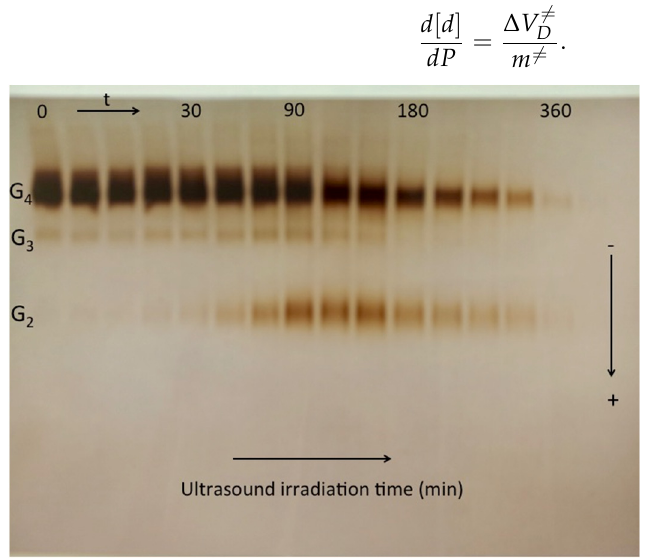
Figure 11. Slab gel PAGE under non-denaturing conditions of human BChE tetramer (G 4 form) following exposure to pulsed ultrasound (85 W) for up to 360 min. The enzyme was revealed by activity staining. The preparation contained 90% of tetramer and less than 10% trimer (G 3 ). Under ultrasound irradiation, a fraction of tetramer dissociated progressively into active “nicked” trimer and dimer (G 2 ) that were slowly inactivated. The dimer is formed of disulfide-bonded monomers (G 1 ). However, G 1 was not transiently observed because the “nicked” monomeric subunits are inactive (unpublished data; for technical details, see [233] ).